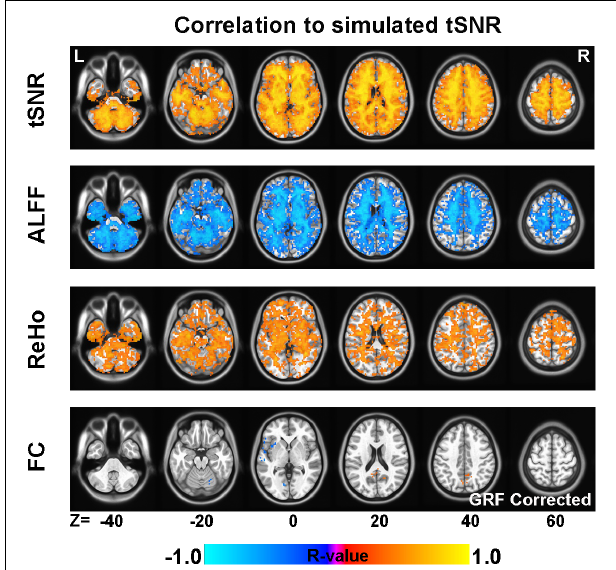
FIGURE 3 | The correlation between temporal signal-to-noise ratio (tSNR) of simulated images and fMRI indices of empirical images. The across-subject correlation between tSNR of simulated images and empirical fMRI indices, including tSNR, amplitude of low-frequency fluctuation (ALFF), regional homogeneity (ReHo), and functional connectivity (FC) (GRF corrected, voxel p < 0.01, cluster p <